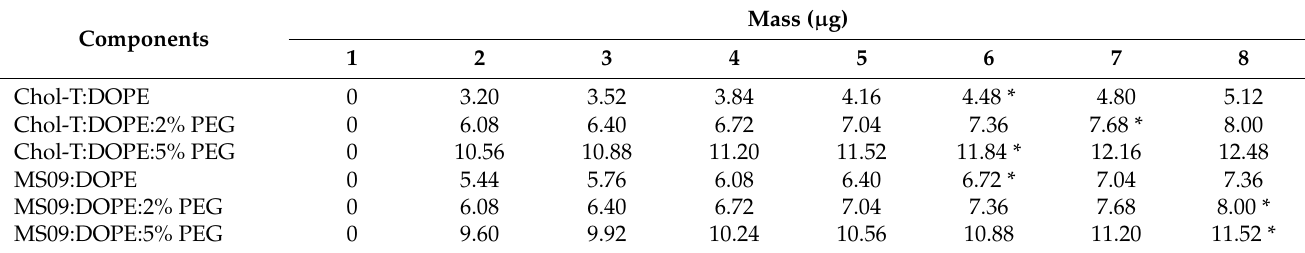
Table 2. Varying amounts ( µ g) of PEGylated and non-PEGylated cationic liposomes were added to siRNA for the band shift assay. Columns 1–8 correspond to the lanes of the agarose